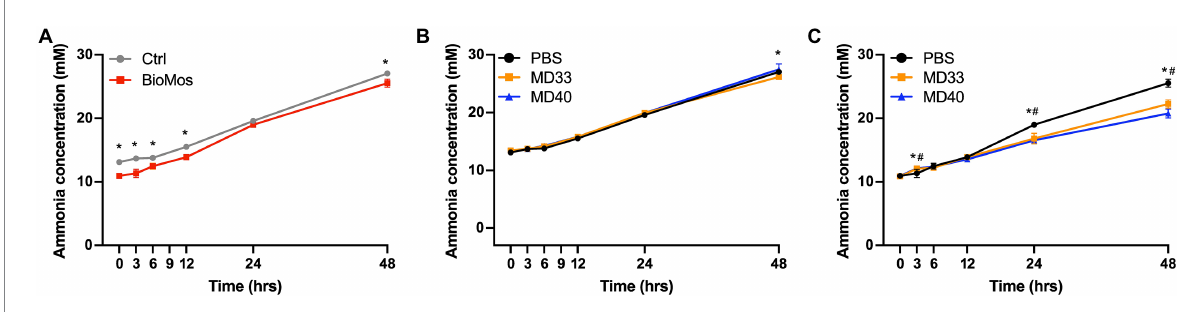
FIGURE 6 Concentration of ammonia produced in ex vivo rumen systems. (A) Concentrations produced in control treatments (no probiotic) of samples collected from cattle fed a control diet (grey) or a diet supplemented with 20 g/day Bio-Mos® (red). *Signifies significant difference ( p < 0.05) between the diet treatments. Samples from cattle fed the (B) Control or (C) Bio-Mos® supplemented diets were inoculated with PBS (control, black), MD33 (orange), or MD40 (blue). *Signifies statistical difference ( p < 0.05) between the control and MD33 treatments. # Signifies statistical difference ( p < 0.05) between the control and MD40 treatments. N =